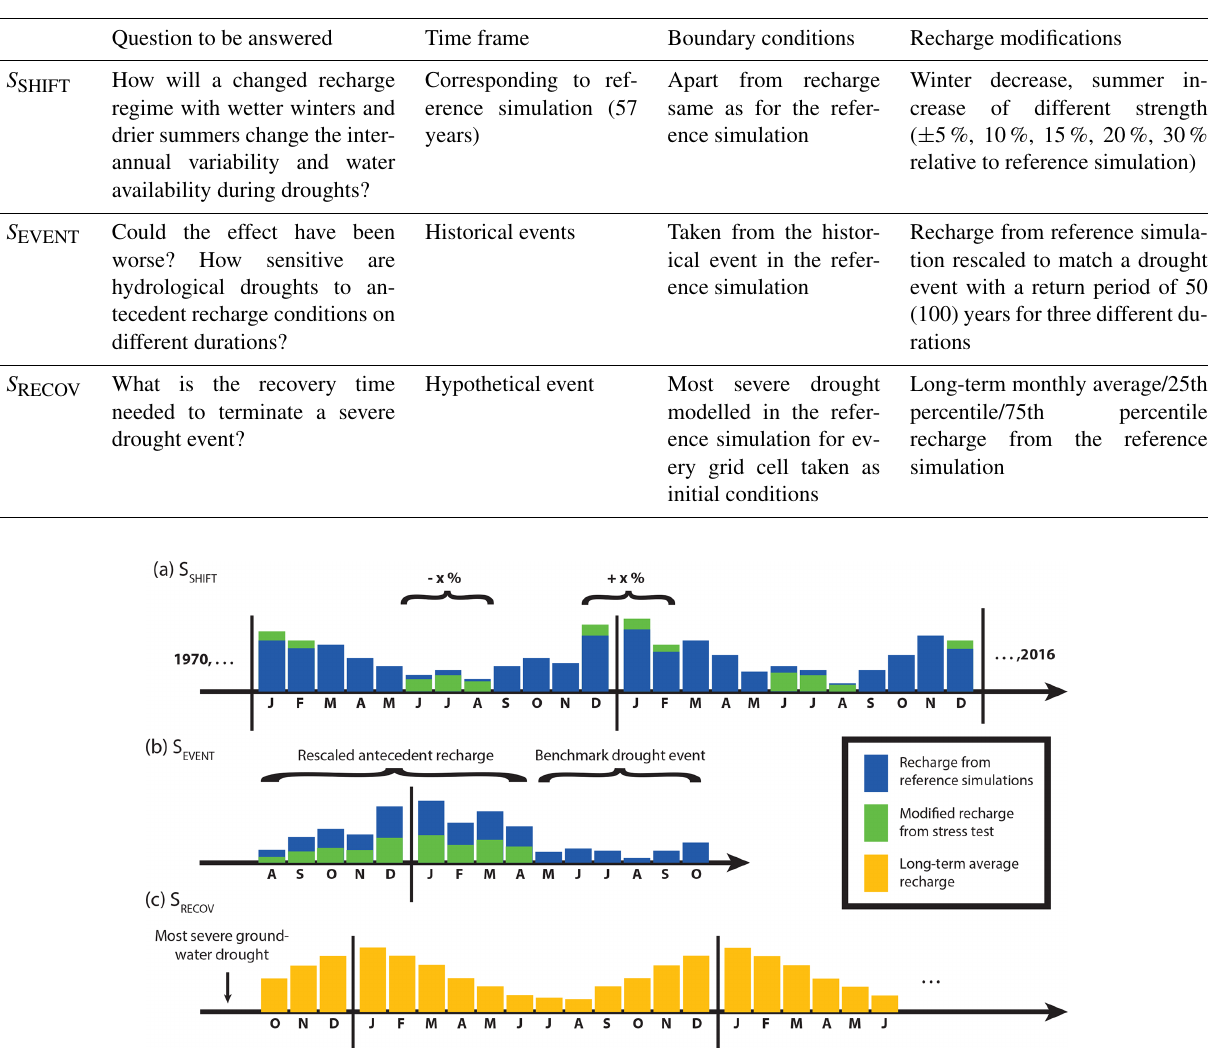
Table 1. Overview of the three generic stress tests used in this study and the related question to be answered by the stress test.